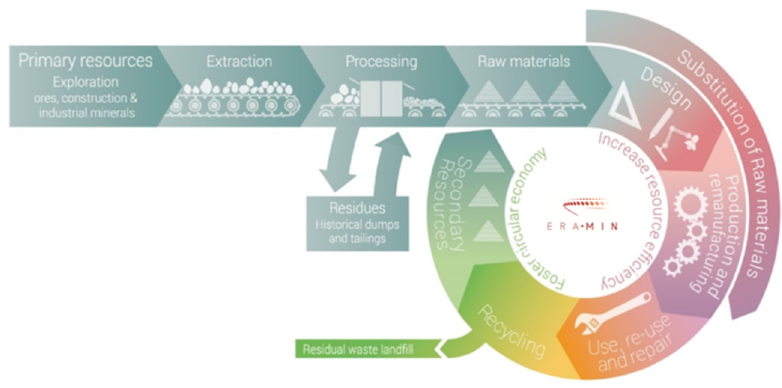
Figure 1. The ERA-MIN view of RM within Circular Economy [9].